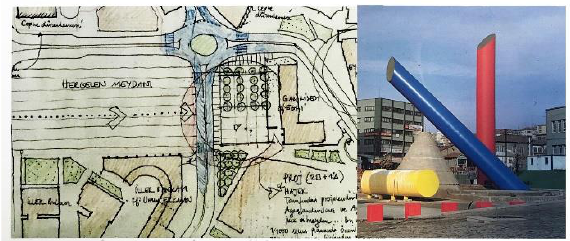
Figure 3: The plan sketch of the Rehabilitation Plan by Raci Bademli and his team and Hajek’s sculpture after completion (Bademli,